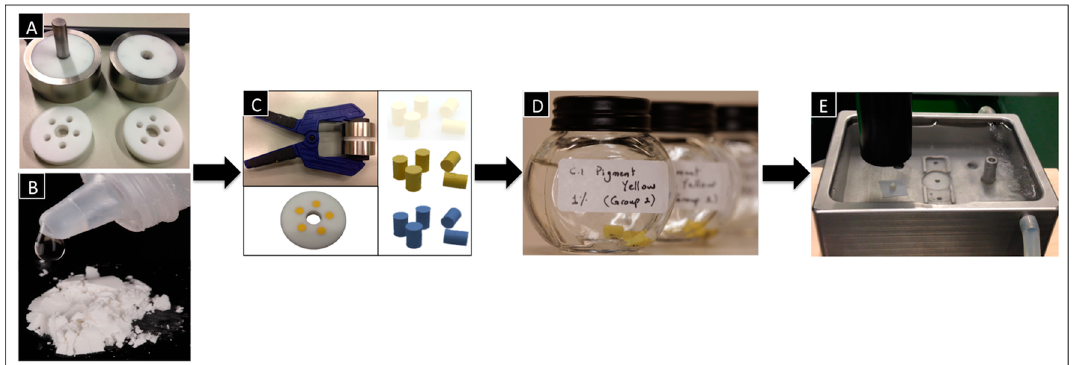
Figure 2. Workflow for the fabrication of the test blocks: ( A ) The Teflon discs engaged in a metal housing with a Teflon disc in between; ( B ) Cement mixing; ( C ) Molding press holding the discs containing the test blocks, then 1 h after setting; ( D ) Test blocks stored in distilled water at 37 °C; ( E ) Compressive strength tests using the universal testing machine (UTM).